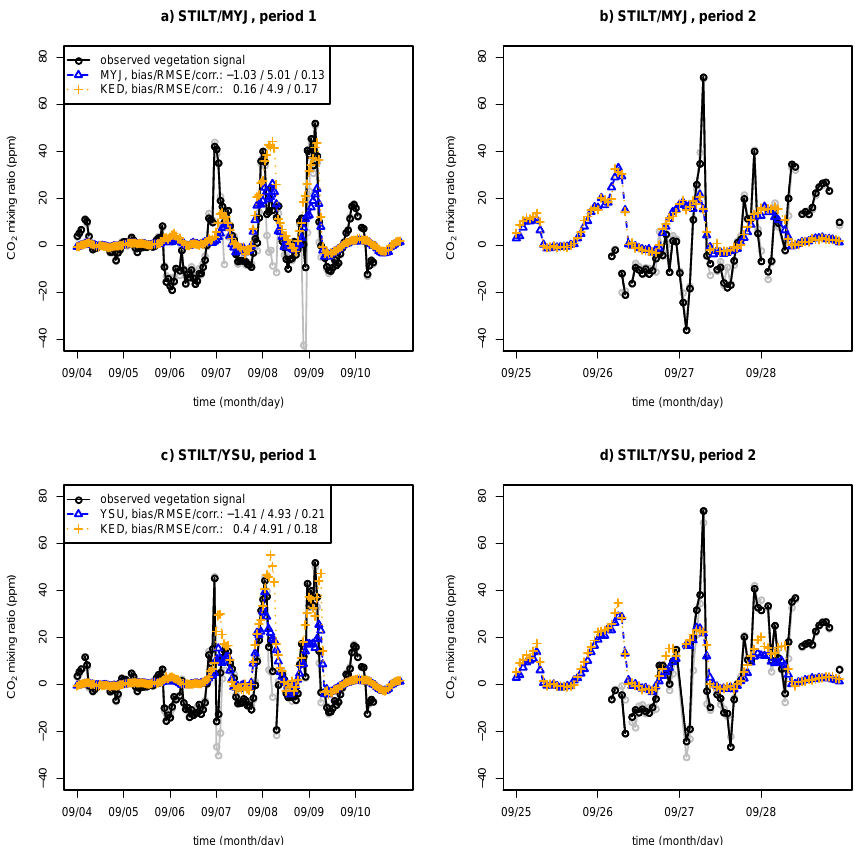
Figure 10. Approximated regional vegetation signal with (grey lines) and without (black lines) optimized MHs during period 1 and 2 of 2009 using the STILT/MYJ model (a, b) and the STILT/YSU model (c, d) at Cabauw 20m (a.g.l.). The observed vegetation signal was derived from modelled and observed CO concentrations by Eqs. (9) and (10). Compared are also the modelled vegetation signals with (orange pluses) and without (blue triangles) using optimized MHs. For both of these variants we calculated the observed vegetation signals shown for comparison with black and grey circles respectively. In the upper left corner of (a) and (c) are summary statistics calculated for the full times series of the signal mismatch: STILT “observations” together with STILT/“observation” squared correlation coefficient ( r 2 ). Statistics are shown for the approximations without MH